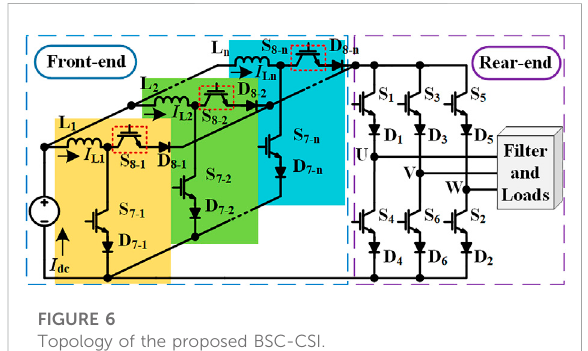
Topology of the proposed